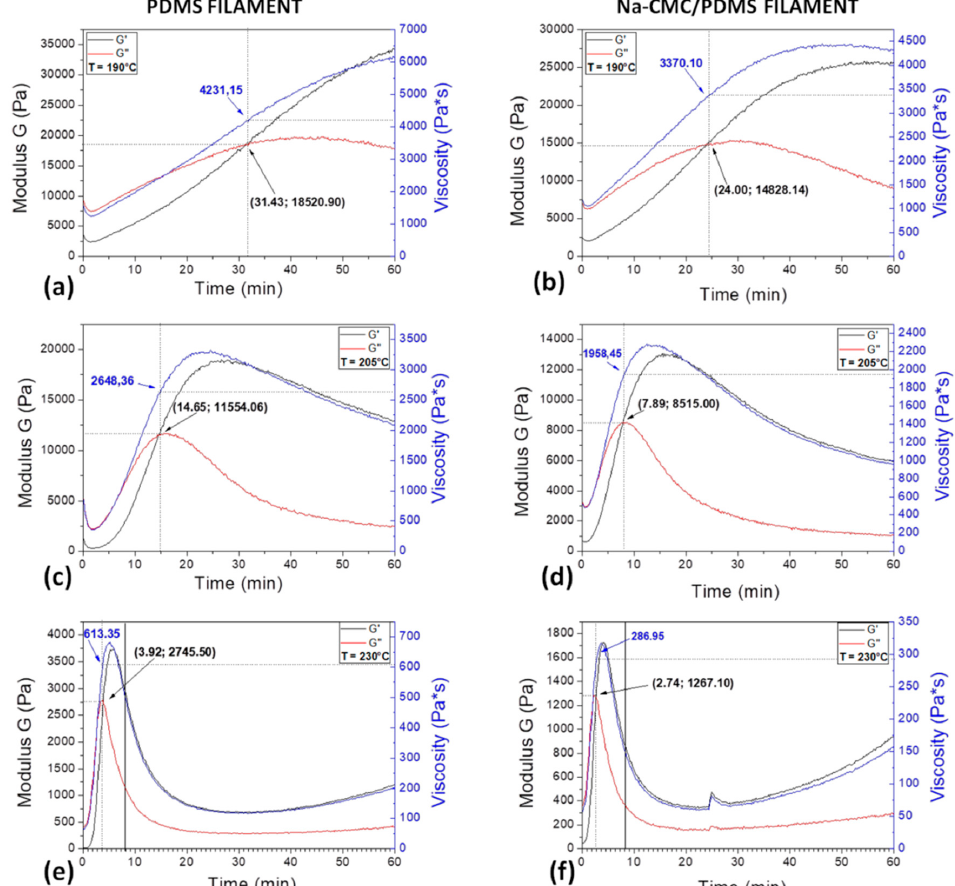
Figure 4. G ′ , G ″ and viscosity curves as a function of time under varying process temperature,